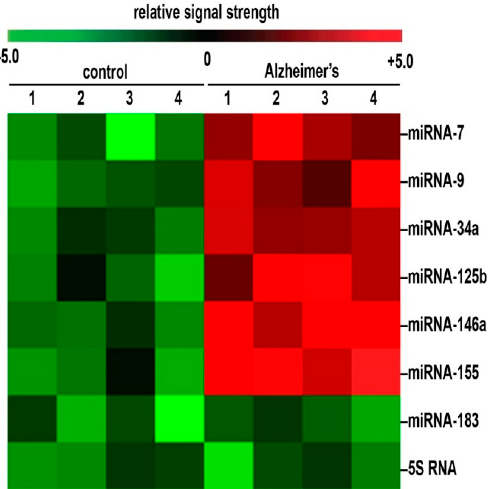
Figure 1. Representative heat map (“color-coded cluster diagram”) of the relative signal strength for six inducible, NF- κ B regulated, pro-inflammatory, CNS-enriched miRNAs in four control and four sporadic Alzheimer’s disease (AD) brains all having post-mortem intervals (PMIs) of ≤ 2.1 h; the most significantly up-regulated miRNAs exhibited relative signal strengths that were miRNA-146a >>> miRNA-155 >> miRNA-125b >> miRNA-34a ≥ miRNA-9 ≥ miRNA-7; up-regulated miRNAs for this group ranged from 2.5-to-6-fold or more over age-matched non-AD controls; the control ncRNAs, including miRNA-183 and 5S RNA, were found not change significantly between age-matched controls and AD; in addition there were no significant differences in ( i ) age (control 71.5 ± 6.1 year; AD 72.2 ± 7.6 year); ( ii ) gender (all samples were from females); ( iii ) PMI (all samples <2.1 h); ( iv ) RNA quality (all samples A 260/280 ~2.1) and/or RNA integrity (RIN) values of >8.5 or higher or ( v ) total RNA yield (all samples had a mean yield of 1.25 μ g RNA/mg wet weight brain tissue) between the control and AD brain samples; these six up-regulated miRNAs have a significant number of sporadic-AD-relevant mRNA targets that can explain much of the discernible neuropathology of the AD brain; (see text; and Figure 2); analogous miRNA profiles for the rarer forms of familial AD have not yet been analyzed to this extent.